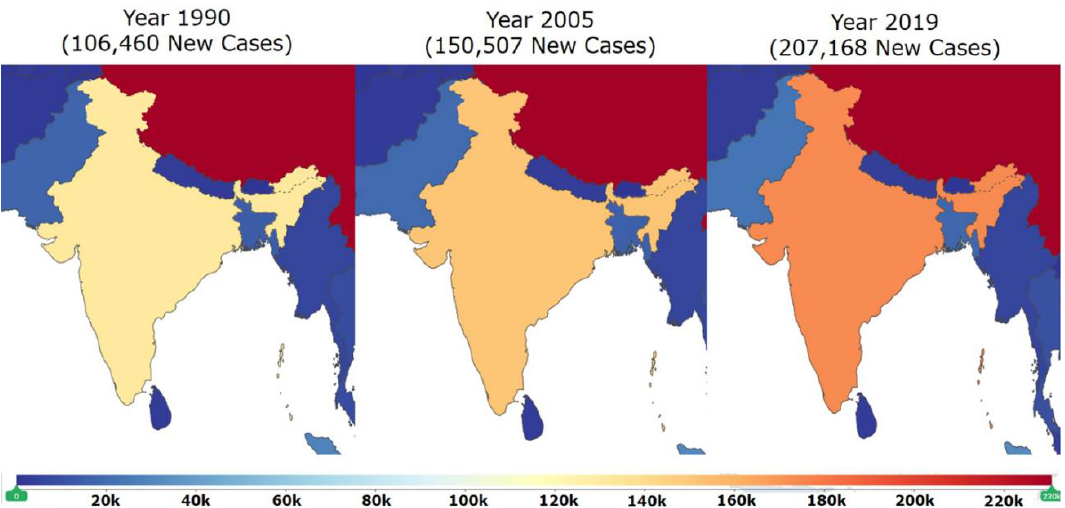
Figure 1. This map of India (modified from Global Burden of Disease; GBD) shows the increase in the incidence of DCM in India in years between 1990 to 2019. There were 106,460 new cases in 1990. Incidents massively increased and 150,507 new cases were reported in 2005. Spike in incidence increased further and 207,168 new cases were reported in 2019. This data clearly indicates that the incidence of DCM is increasing at an alarming rate in India [Adapted with permission from IHME, Seattle, USA “Source: Institute for Health Metrics Evaluation. Used with permission. All rights reserved” [15]. Accessed on 18 April 2021].